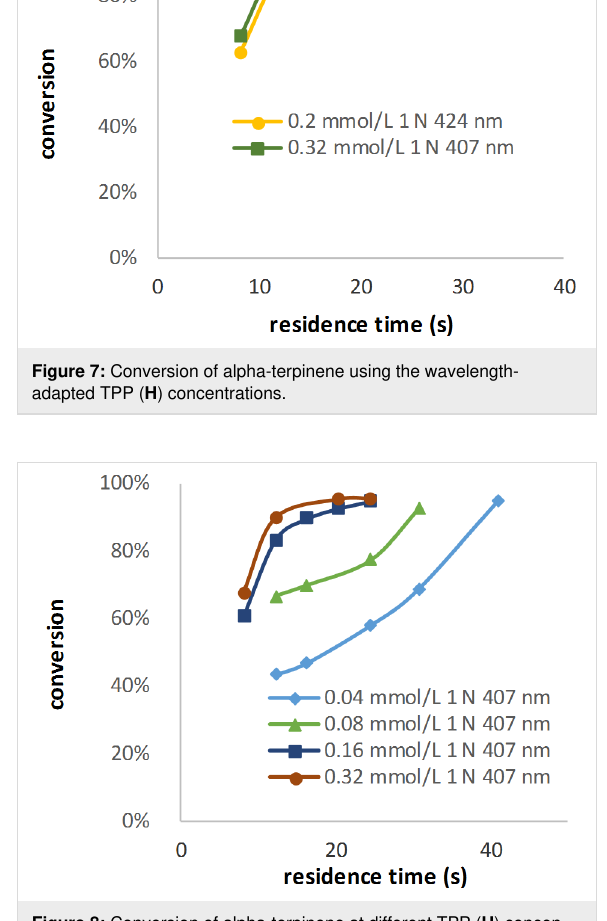
Figure 8: Conversion of alpha-terpinene at different TPP ( H ) concen- trations.